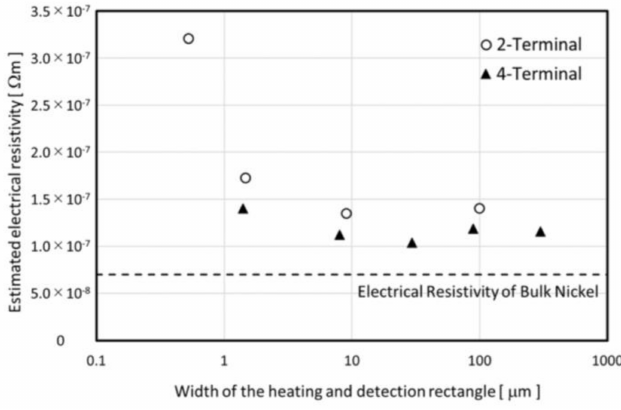
Figure 15. Estimated electrical resistivity as functions of the width of the rectangle pattern.